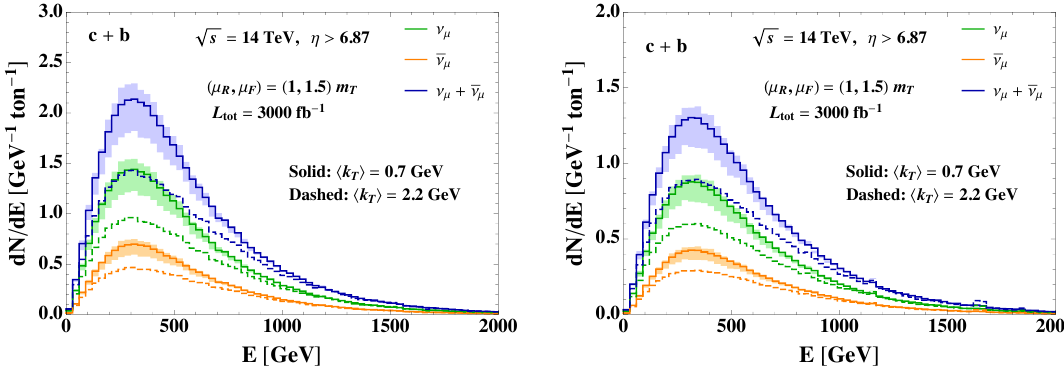
Figure 9 . Our predictions for the muon neutrino and antineutrino number of charged current events per GeV for 1 ton of lead target as a function of the incident neutrino energy for neutrinos with a pseudorapidity (cid:17) > 6 : 87 generated by heavy-(cid:13)avor decays in pp collisions with value of h k T i = 0 : 7 GeV is adopted for the central predictions, while the uncertainty bands